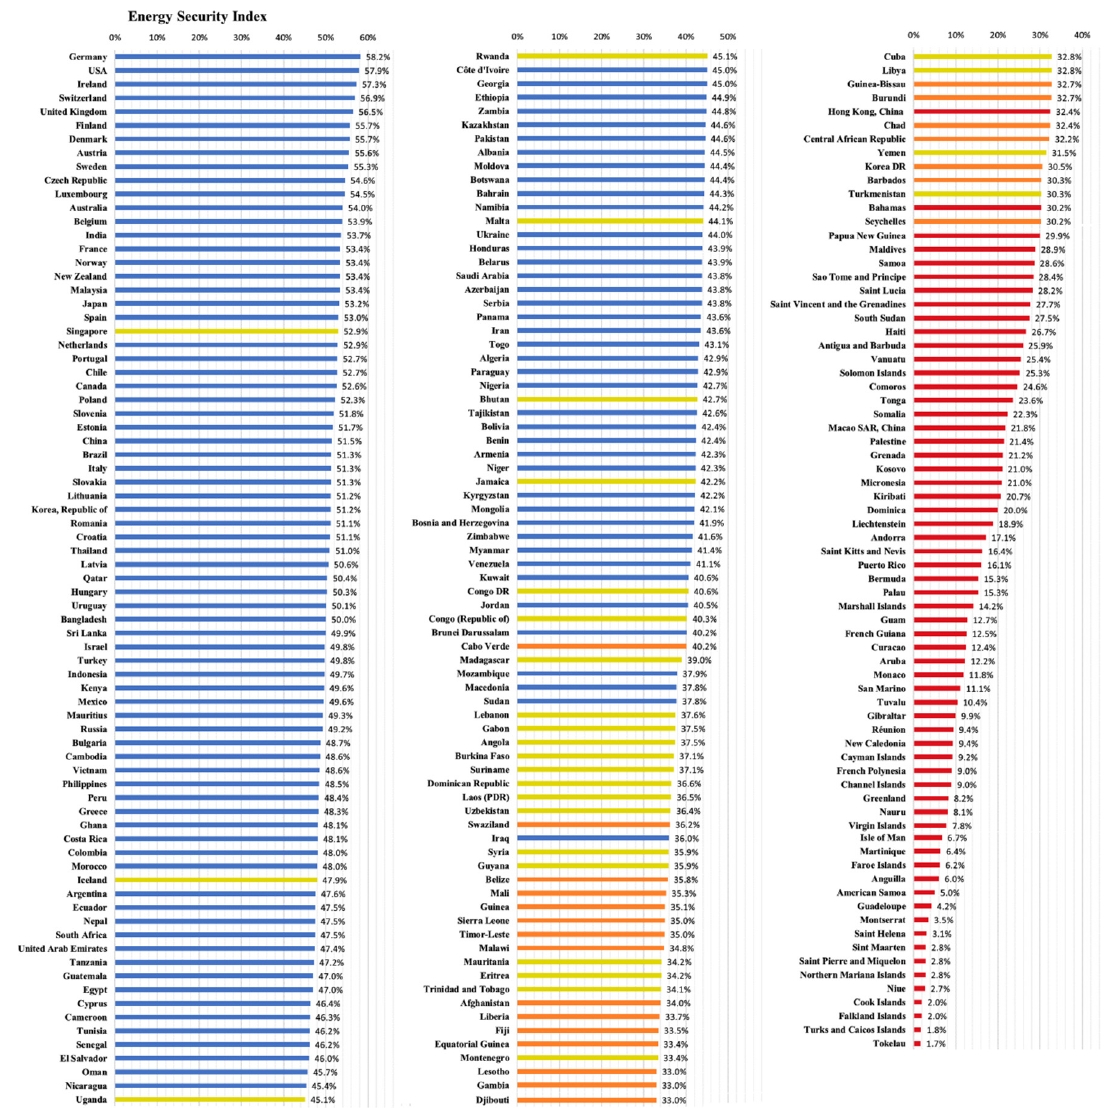
Figure 1. Global energy security levels. The applied colour of the bars indicates the number of missing parameters: blue ≤ 5, yellow 5 ≤ 10, orange 10 ≤ 15, red >